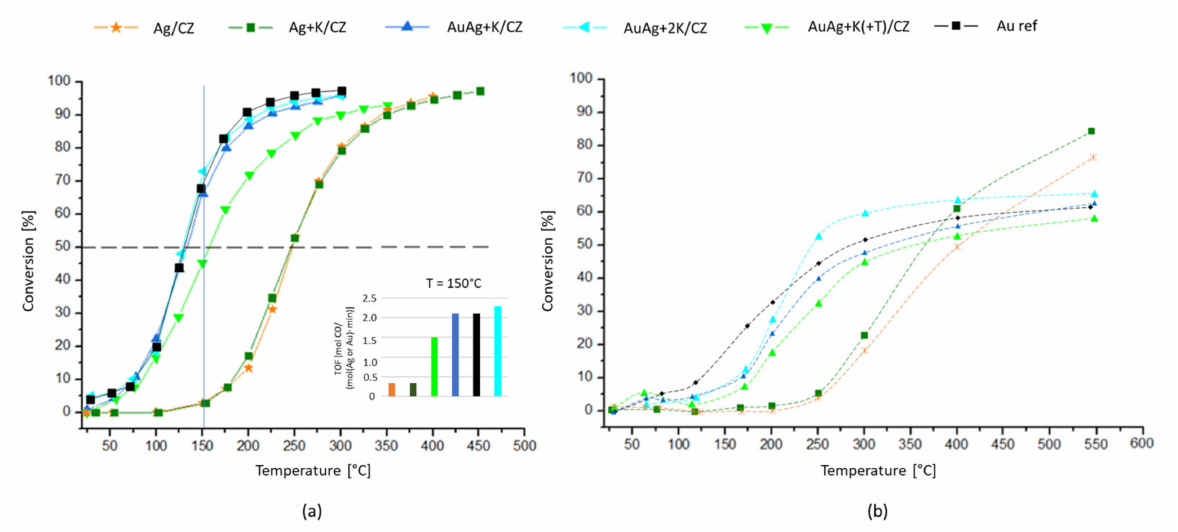
Figure 7. Activity results: CO conversion on catalysts in ( a ) a model stream, and ( b ) in a complex reagent stream without water; inset: TOF value calculated for 150 ◦ C for the model stream using either Ag for monometallic silver system or Au for bimetallic